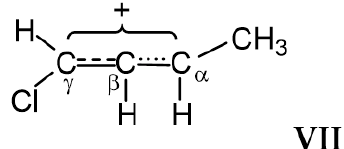
Scheme 8. Structure of isomer VII according to NMR and IR